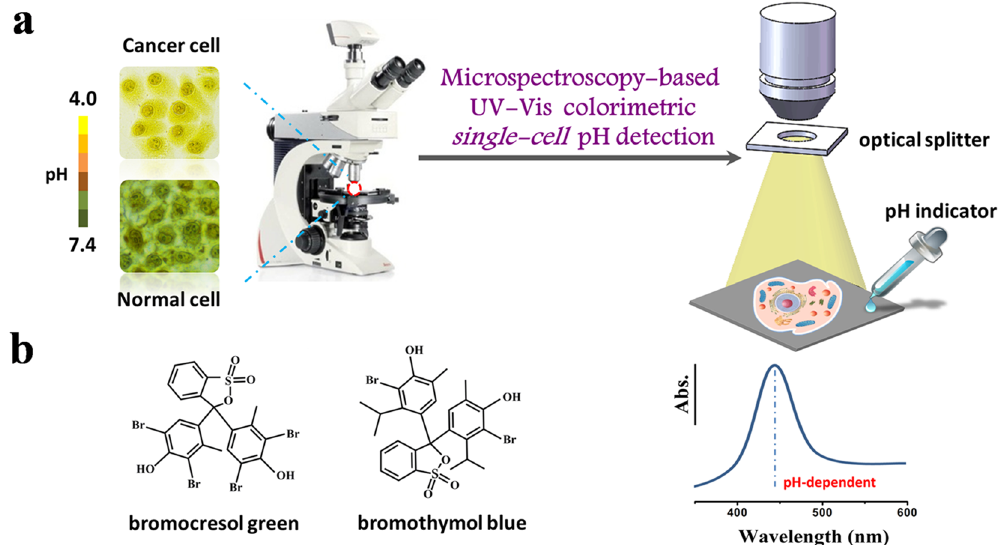
Figure 1. Schematic of colorimetric single-cell pH imaging and detection with two pH indicators. ( a ) Schematic of single-cell pH imaging and detection by combined use of bright-field microscope-based UV-Vis microspectroscopy and common pH indicators. A selected area single-cell absorption spectrum is collected by an optical microscope equipped with a portable spectrometer and an optical splitter with a small collecting area. ( b ) The structures of two pH indicators used in this